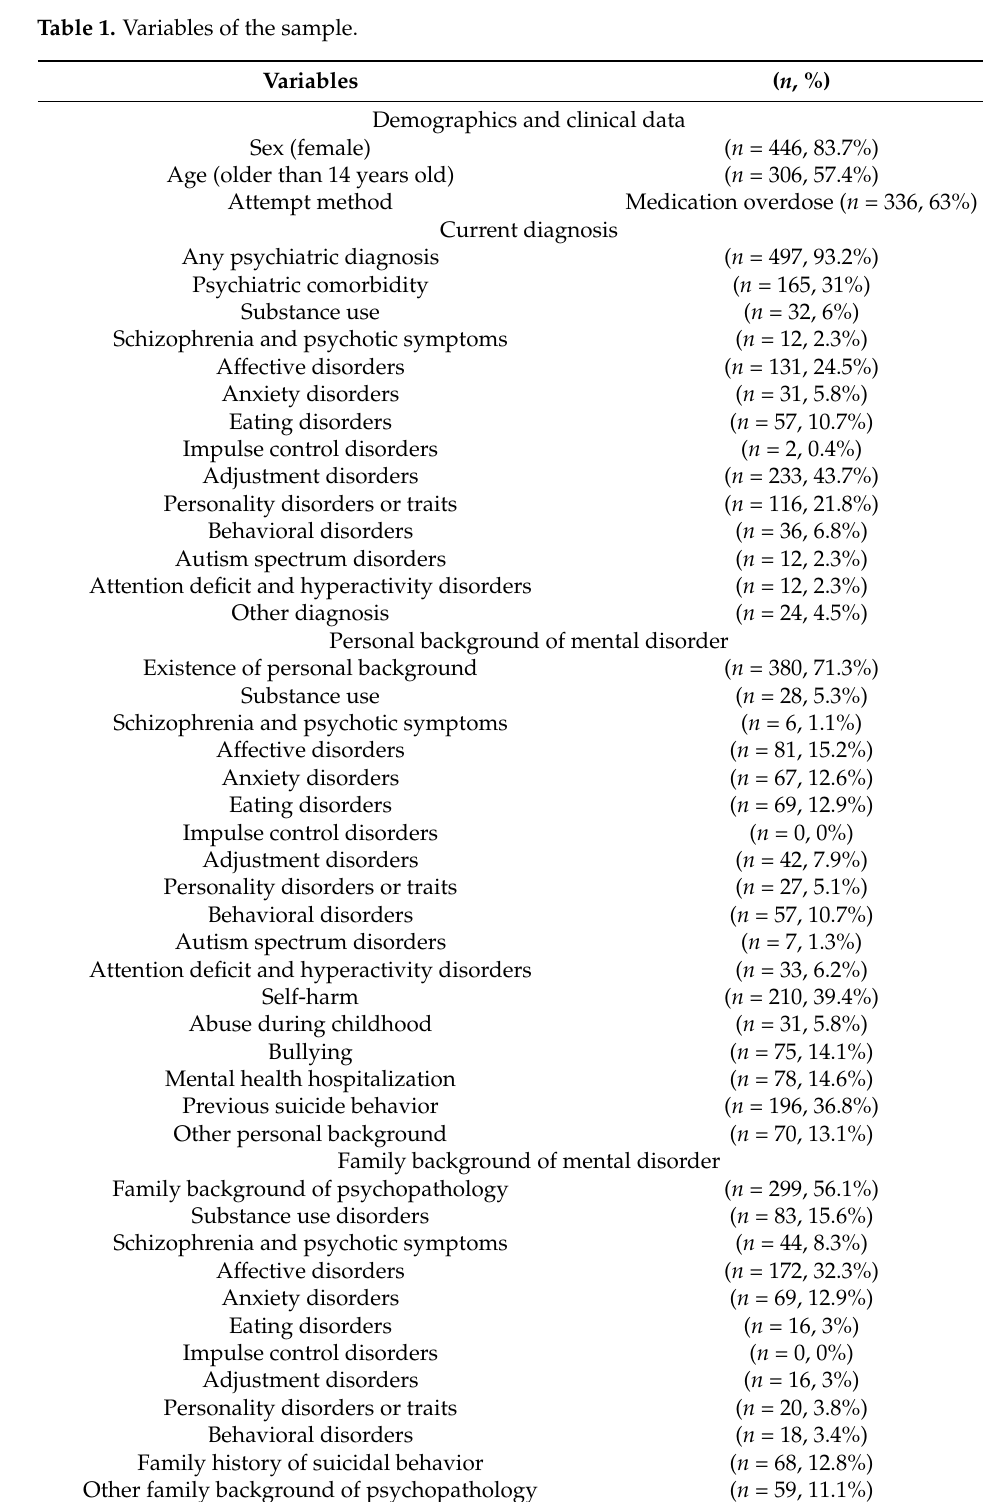
Table 1. Variables of the